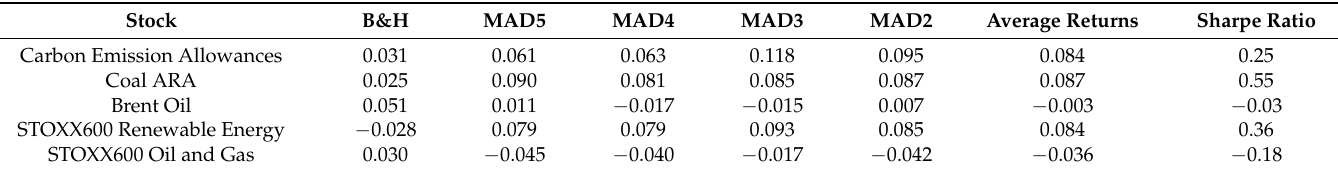
Table A4. Annualized daily (every other month) returns of MAD2–MAD5 (D = every other month, 5, 4, 3, 2, are the numbers of observations in the rolling window), average returns and Sharpe ratios.